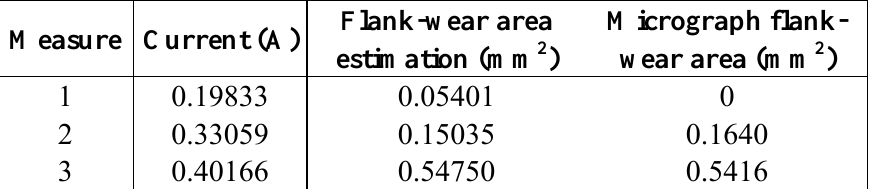
Table 4. Flank-wear area results by current and tool micrograph.